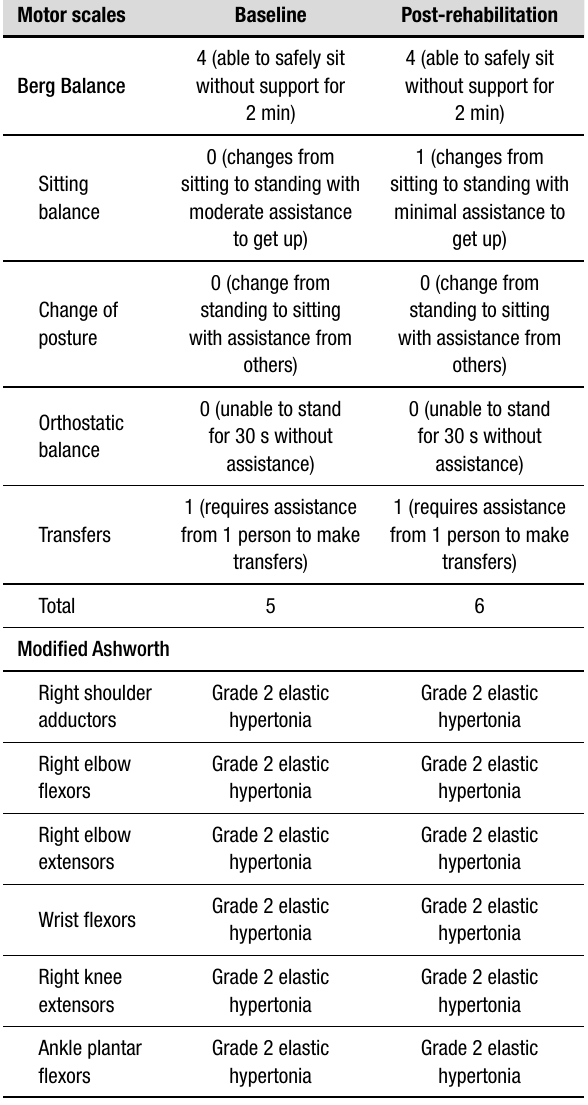
Table 1. Motor assessment before and after 3 months of rehabilitation. Motor scales Baseline